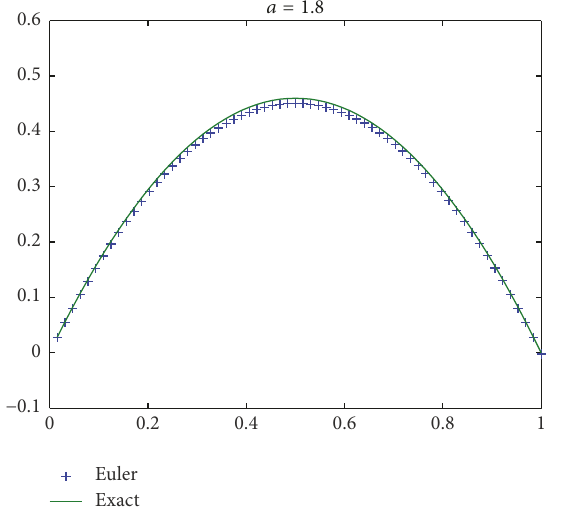
Figure 2: The behavior solution at 𝑇 = 1 with Δ𝑡 = ℎ = 2 −6 , 𝛼 = 1.8 .